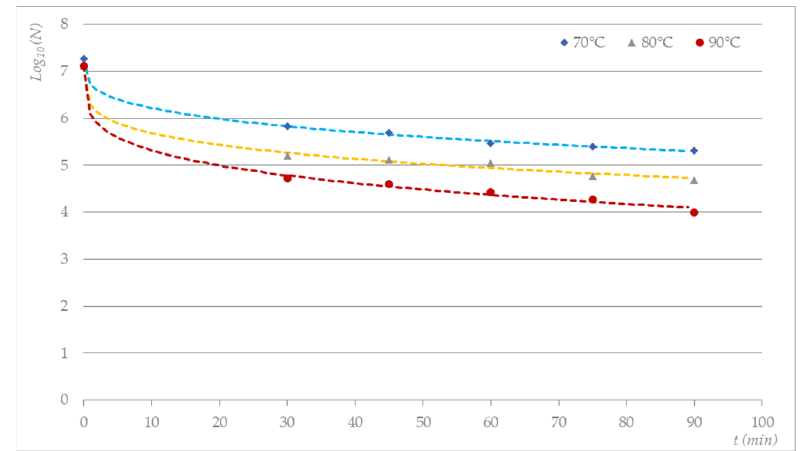
Figure 3. Measured and predicted surviving S. aureus microorganisms on textile bioindicators thermally treated in a heating oven based on the Weibull prediction model (GInaFIT v1.7).